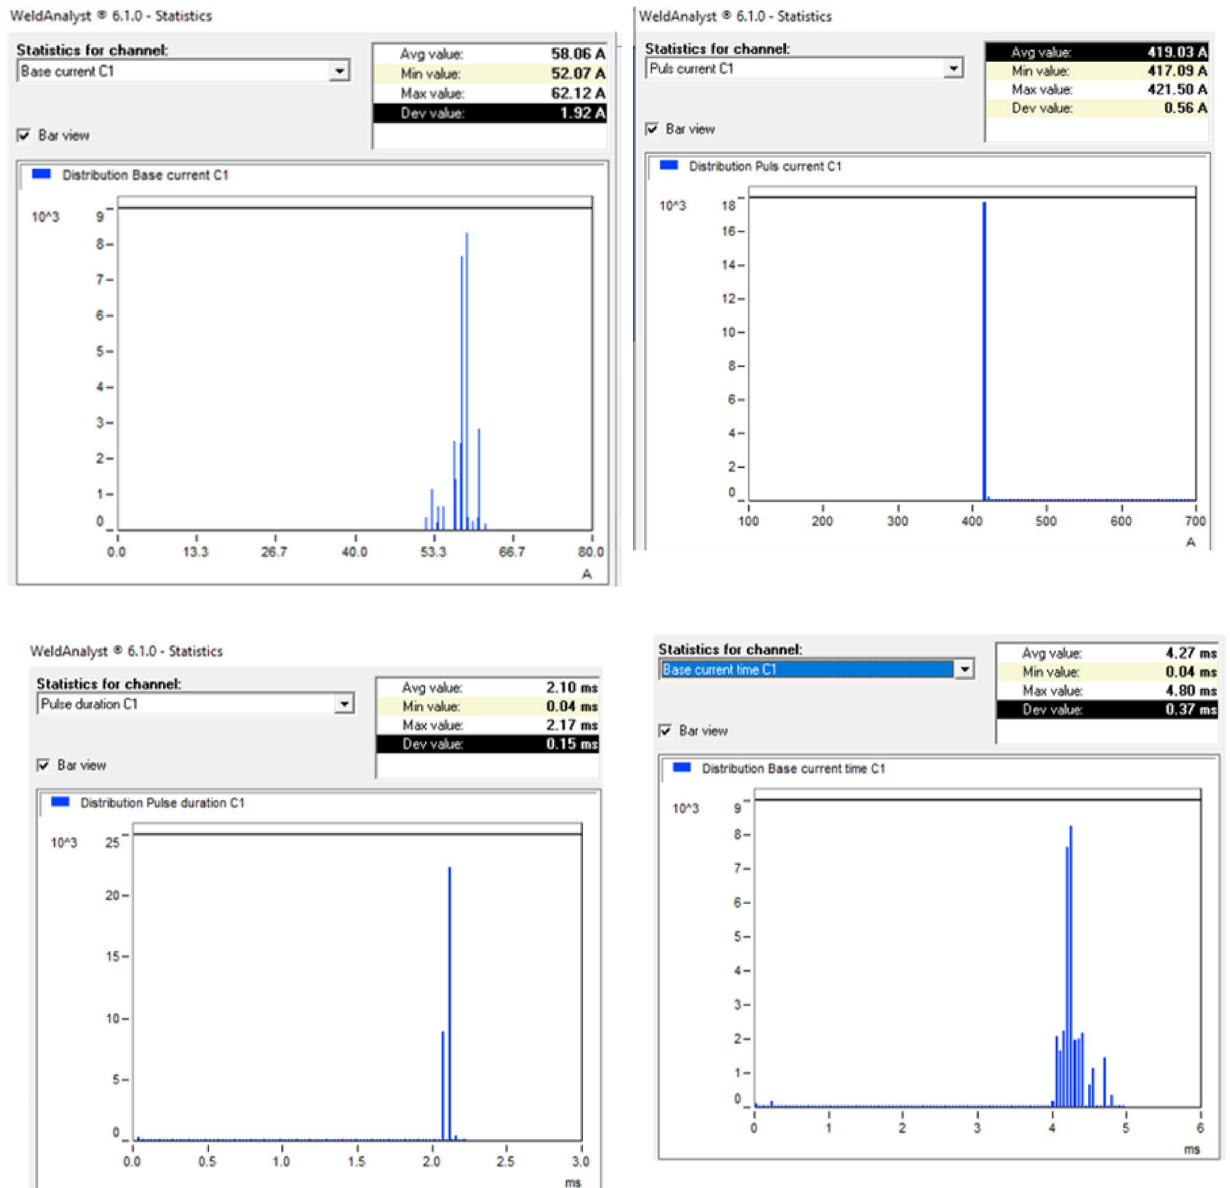
Fig. 14 Exponential waveform distribution chart as generated from web